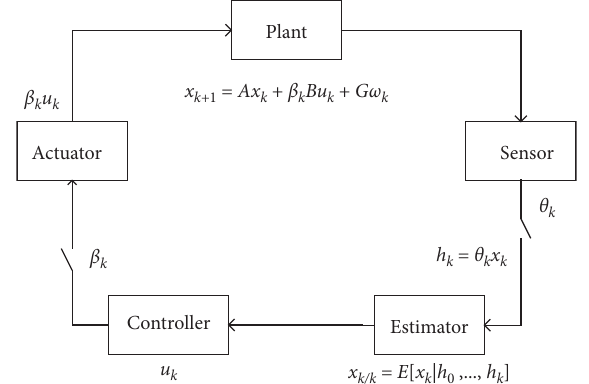
Figure 1: NCS model with two kinds of Markovian packet